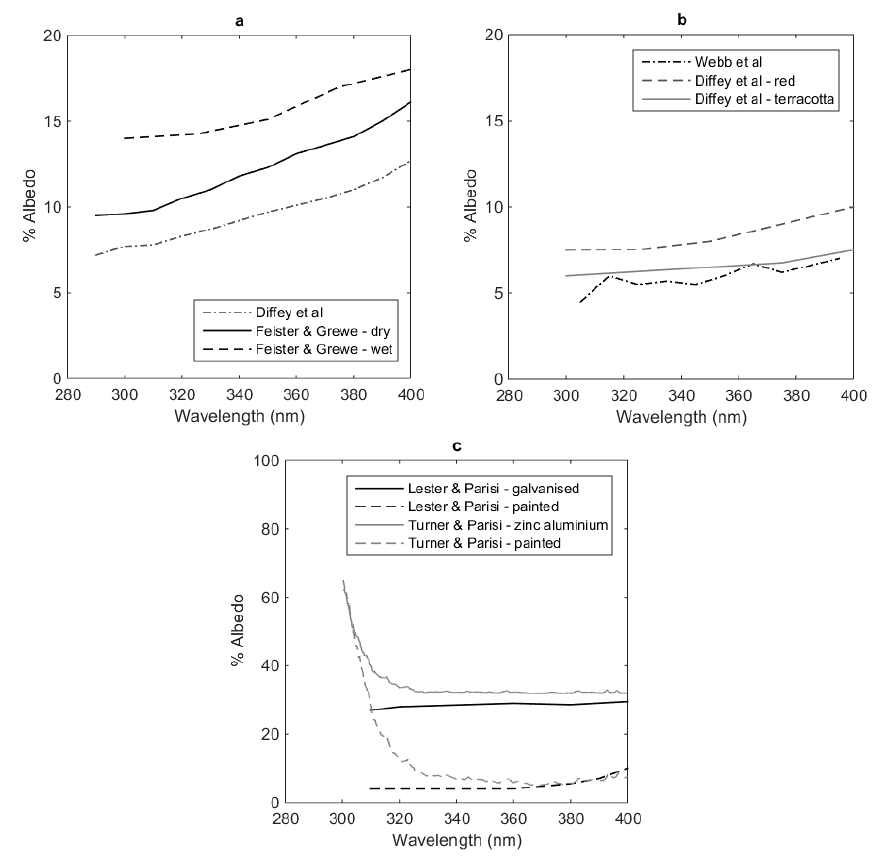
Figure 2. Spectral UV albedo of ( a ) concrete, ( b ) brick ground cover and ( c ) metal (steel) horizontal surfaces. The data has been collated from Feister and Grewe (F&G) [27], Diffey et al. [26], Webb et al. [36], Lester and Parisi (L&P) [30] and Turner and Parisi (T&P) [48,51].